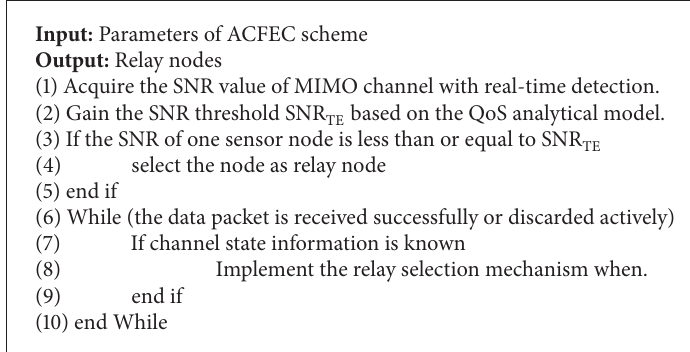
Algorithm 2: Relay selection algorithm of ACFEC at relay